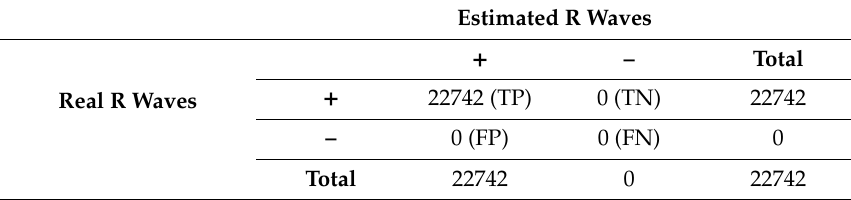
Table 2. Performance of the proposed method in detecting R-wave